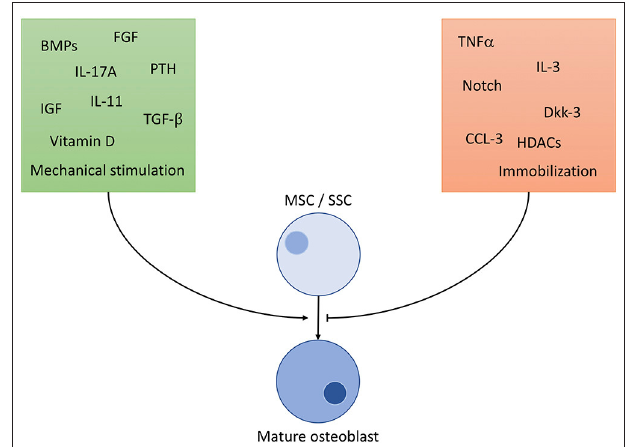
FIGURE 1 | Selected important players of osteoblast differentiation. Promoting factors (green square) include: BMP: bone morphogenic proteins of the TGF- β superfamily, a large ( > 20) group of anabolic proteins secreted by different cells to ensure development of bone, cartilage and tendons mainly via the Runx2 axis. TGF- β : transforming growth factor β 1 − 3 , contained in bone cartilage tissue in large amounts. Regulates osteoblast differentiation and development similar to BMPs, with additional anti-inflammatory properties. IGF: insulin like growth factor, mainly promotes osteoblast activity, but also has positive effect on differentiation. FGF: fibroblast growth factor, stimulates OB differentiation in a manner similar to BMP signaling (Runx2 pathway). IL-11: is directly induced by mechanical strain in bone and PTH signaling and downregulates effects of Wnt inhibitors like Dkk-1/2. IL-17A: effects depend on targeted cell type. MSC differentiation is supported, but calvarial preosteoblasts receive negative effects. PTH: parathyroid hormone, only stimulates OB differentiation through Runx2 if elevation of PTH is intermittent, continuously elevated levels result in bone resorption. Vitamin D: complexes Runx2 and other cofactors to upregulate osteoblast specific genes. Mechanical stimulation promotes bone growth and OB activity according to Wolff’s law: bone structure forms according to applied force. Inhibiting factors (orange square): TNF α : supposedly hampers with differentiation through inhibition of IGF-1, BMP-2/6 and possibly guiding SSCs to lineages other than osteoblasts. Dkk: the Dickkopf ligand family are potent inhibitors of the Wnt pathway, thus inhibiting development. HDCAs: histone deacetylases, prominently HDCA3-7 inhibit Runx2-DNA interaction, interfere in gene translation. CCL-3: also known as macrophage inflammatory protein 1- α (MIP-1- α ) promotes inflammation and osteoclast activation. Additionally, it blocks the Runx2 pathway in OBs. Notch: effects of Notch on OBs are not fully clarified, although findings constitute a hampering function by Runx2 inhibition. Immobilization: absence